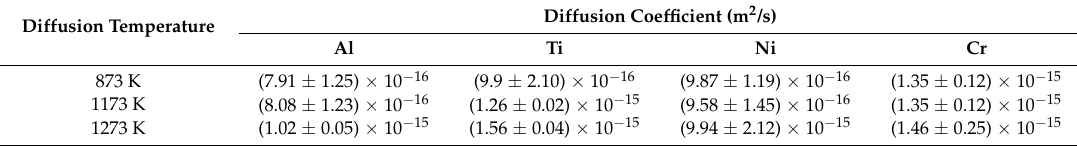
Table 7. Diffusion coefficients of the main elements of the ceramic tools and Inconel 625 (90